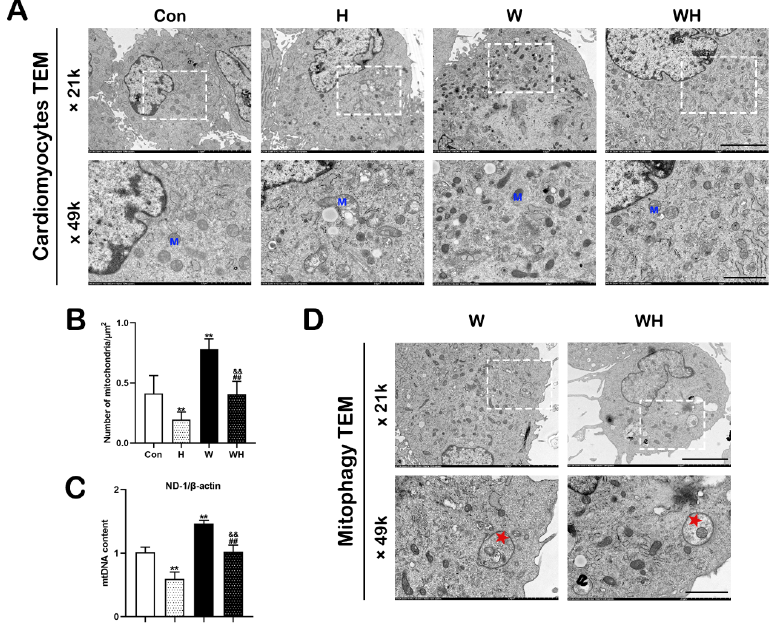
Figure 6. WA increased the mitochondrial number and enhanced autophagic flux in cardiomyocytes. ( A ) Representative electron micrograph of cardiomyocytes from each group. The dashed boxes correspond to the enlarged regions. M, mitochondria. Scale bars = 5 μ m (21 K×), 2 μ m (49 K×). ( B ) Number of mitochondria per μ m 2 . Mitochondria were counted in six randomly selected TEM visual fields per group. ( C ) mtDNA content in cardiomyocytes, as evaluated by qPCR. ( D ) Represen- tative electron micrograph showing autophagosomes in cardiomyocytes in the W and WH groups, as indicated by the red pentagrams. The values are presented as the mean ± SEM of three independent experiments ( n = 3). ** p < 0.01 vs. the Con group. ## p < 0.01 vs. the H group. && p < 0.01 vs. the W